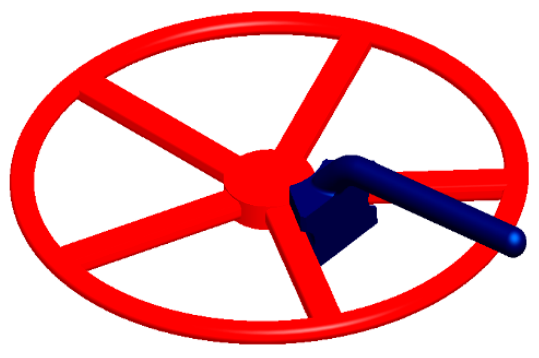
Figure 4. Novel spanner concept.